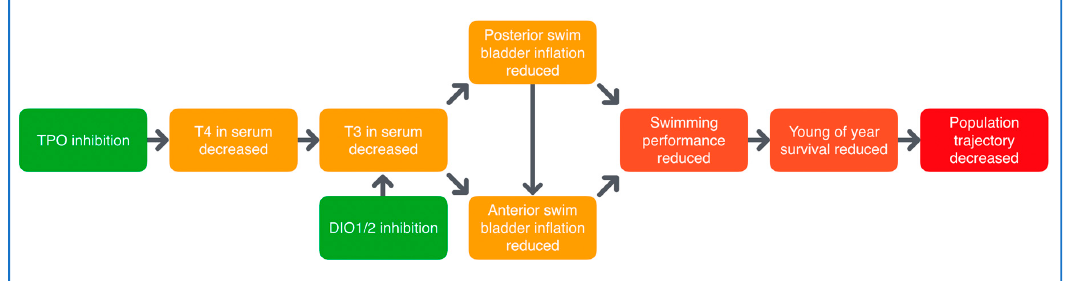
Figure 2. Putative AOP network for deiodinase (DIO) and thyroperoxidase (TPO) inhibition, leading to impaired swim bladder inflation in fish. DIO inhibition causes triiodothyronine (T3) serum decrease and reduced anterior swim bladder inflation, with reduced swimming performance and survival as adverse consequences. https://aopwiki.org/aops/155-159.